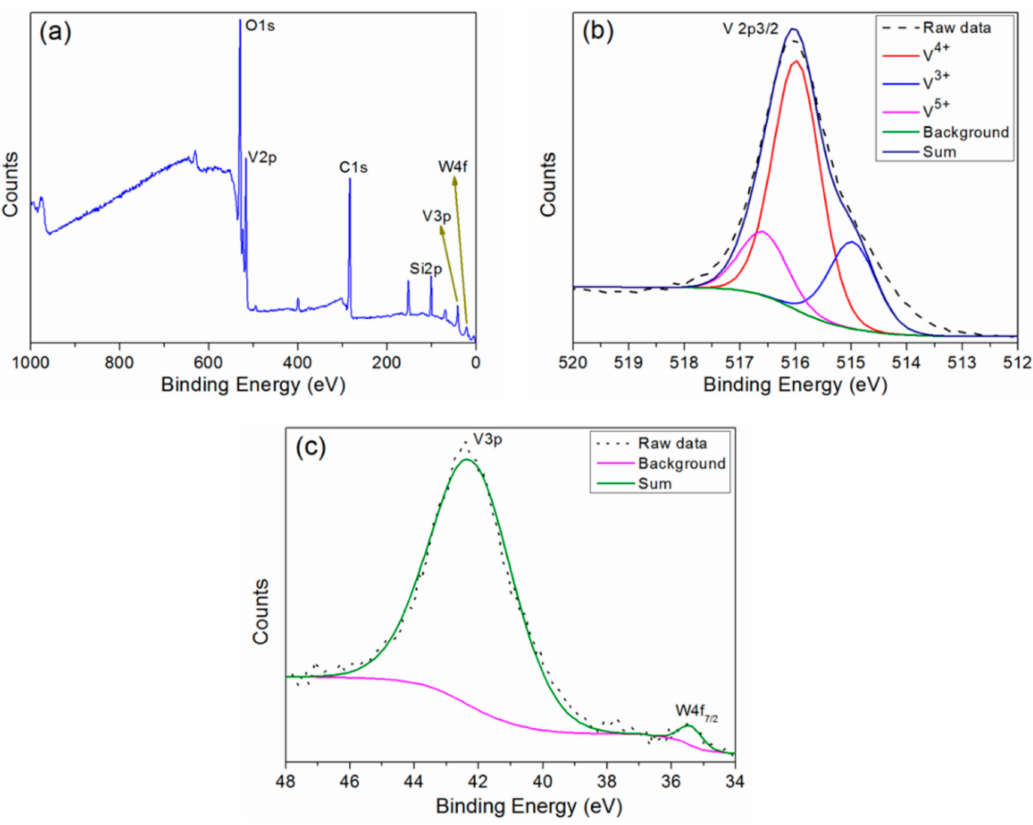
Figure 5. Typical XPS spectra of the W-doped VO 2 film: ( a ) survey spectrum and high-resolution scans of ( b ) V 2 p 3/2 and ( c ) W 4 f 7/2 .